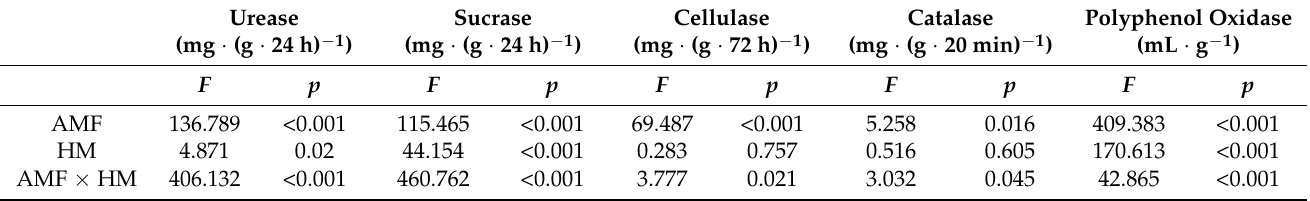
Table 3. The Two-way ANOVA analysis of heavy metal stress and AMF infection on the enzyme activities of